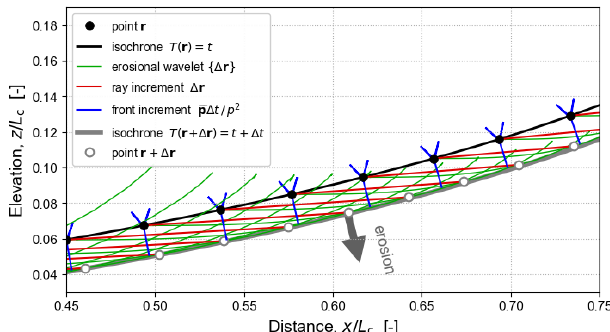
Figure 4. Incremental erosion (for η = 3 with L visualized as an erosional wavelet (green curve), i.e. a ve- locity indicatrix, with the point-motion ray vector in red and front- normal-motion covector in blue.